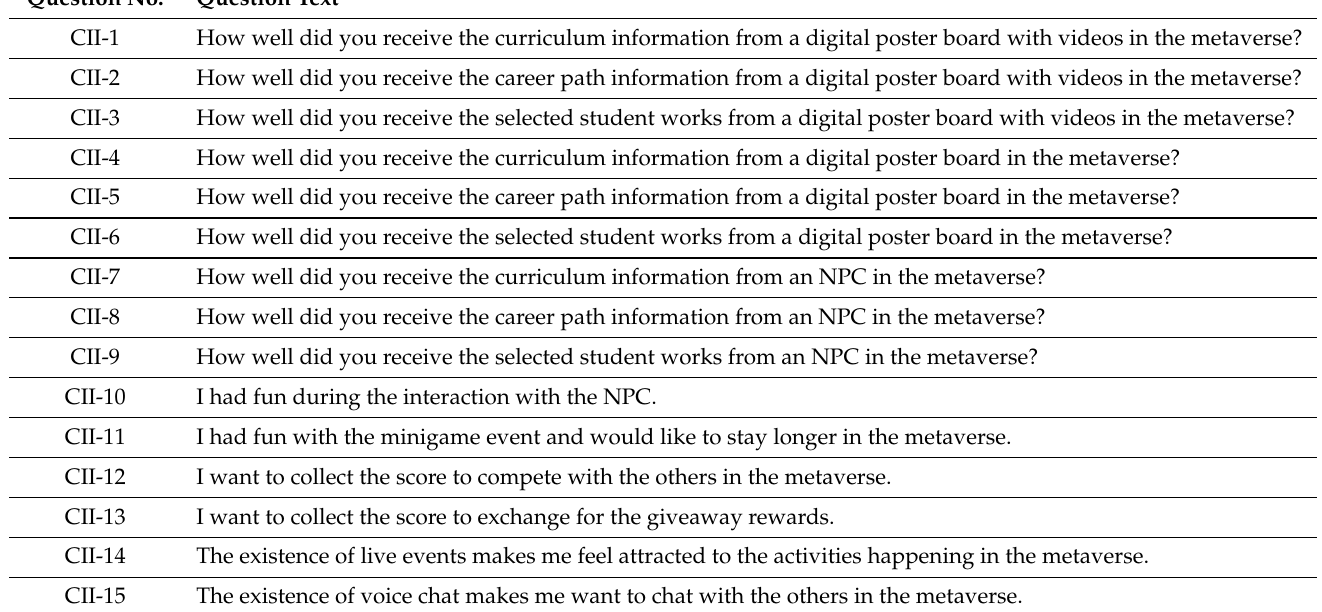
Table 4. A list of the 15 CII quantitative questions. This questionnaire set was used to collect feedback specifically on the platform features’ ability to convey the intended information